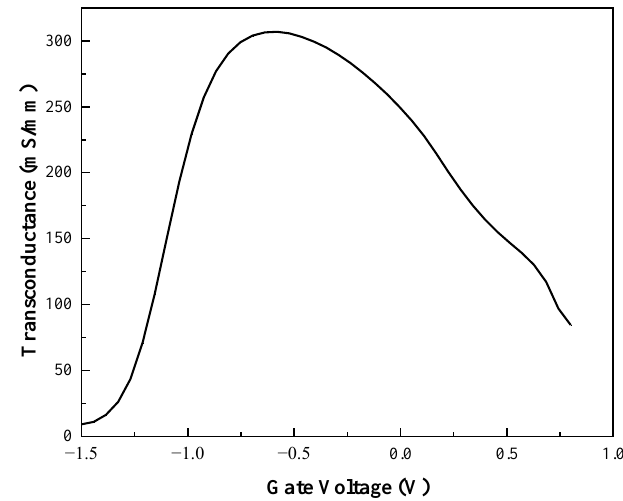
Figure 9. The direct current under UWB pulse jamming.